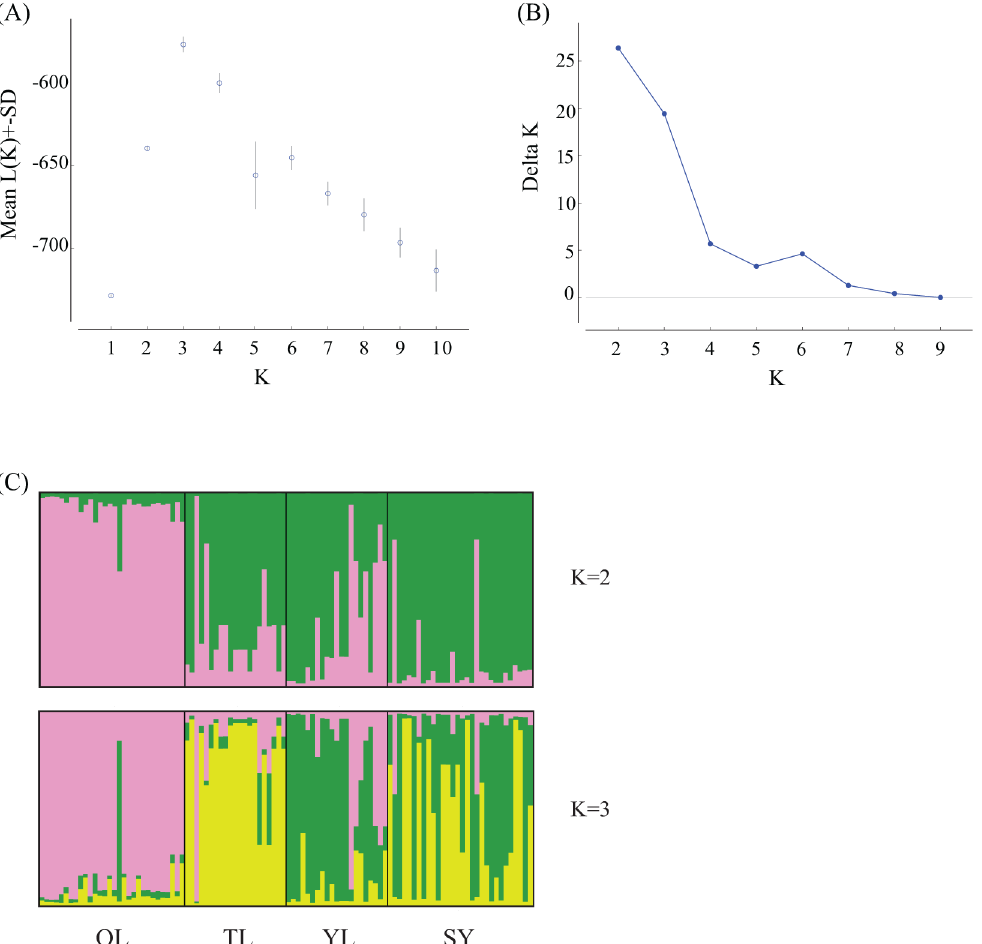
Fig 2. Results of the Bayesian clustering analysis. (A) The mean L(K) and its standard deviation for each K. (B) The delta K value for each K. (C) The histograms of the frequencies of the genetic components for each individual when K = 2 and K = 3.